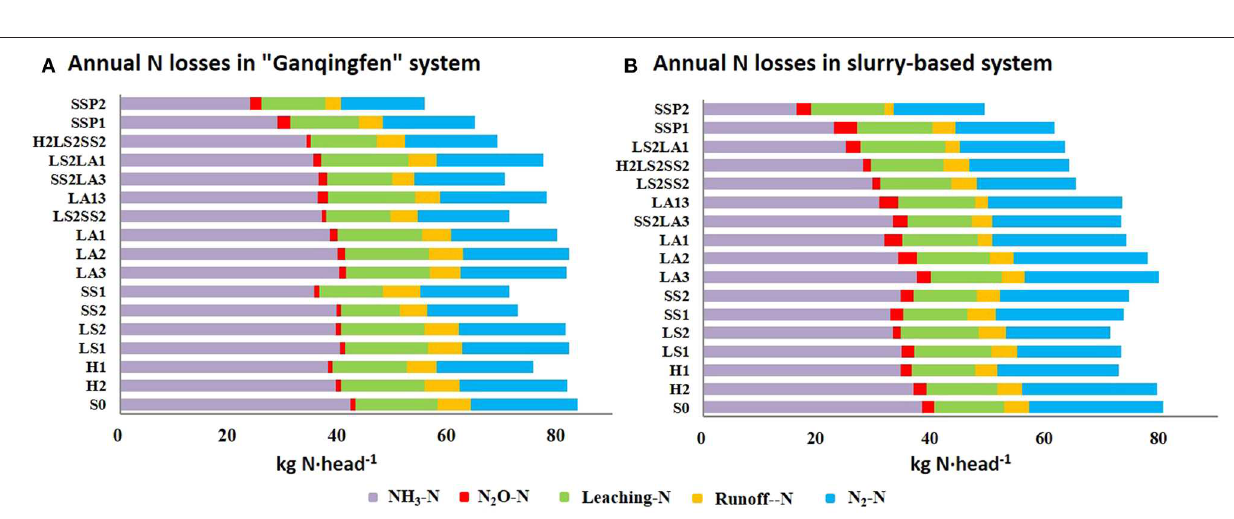
Frontiers in Sustainable Food Systems |